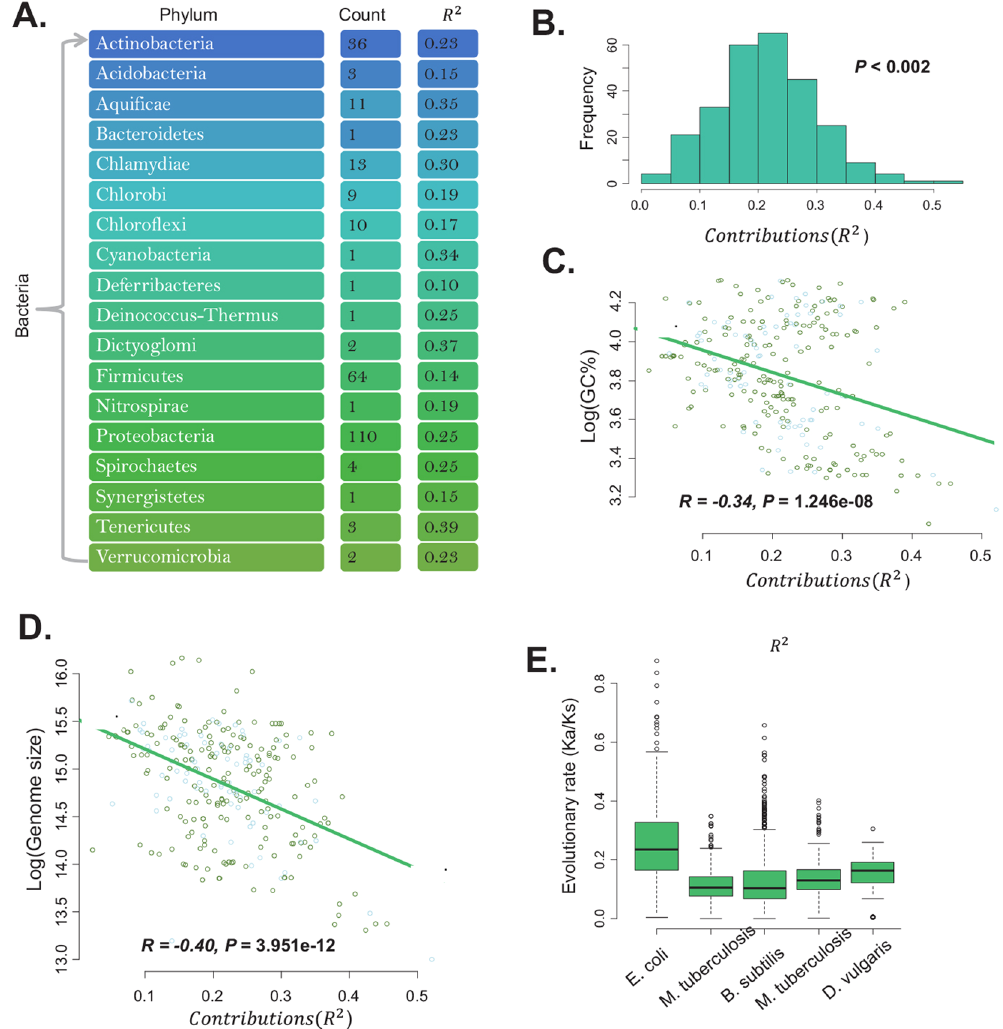
Figure 1. Multivariate linear regression models between amino acids and evolutionary rates. ( A ) There are 273 genome pairs belong to 18 phyla. Corresponding genome pair count and the average R 2 for the multivariate linear regression between amino acid compositions and evolutionary rates were shown. ( B ) For 273 organisms, the total decision coefficient R 2 ranged in 0~0.6 with P is less than 0.05. ( C ) GC content influences the total decision coefficient R 2 for the multivariate linear regression between amino acid compositions and evolutionary rates. ( D ) Genome size negatively correlates with the total decision coefficient R 2 . ( E ) The evolutionary rates for proteins in the five model organisms and corresponding average are: 0.26, 0.11,0.13,0.16, and